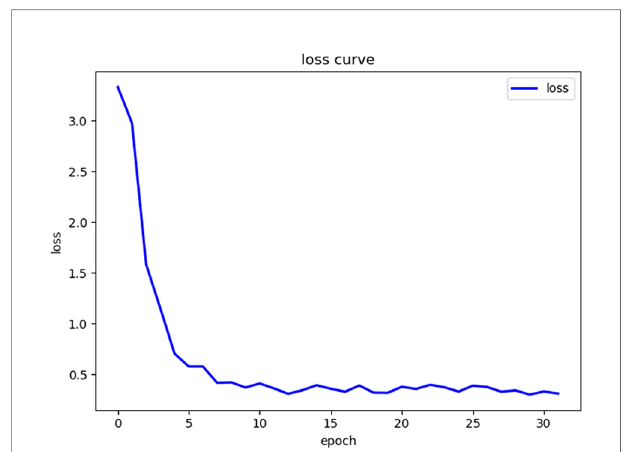
function value gradually